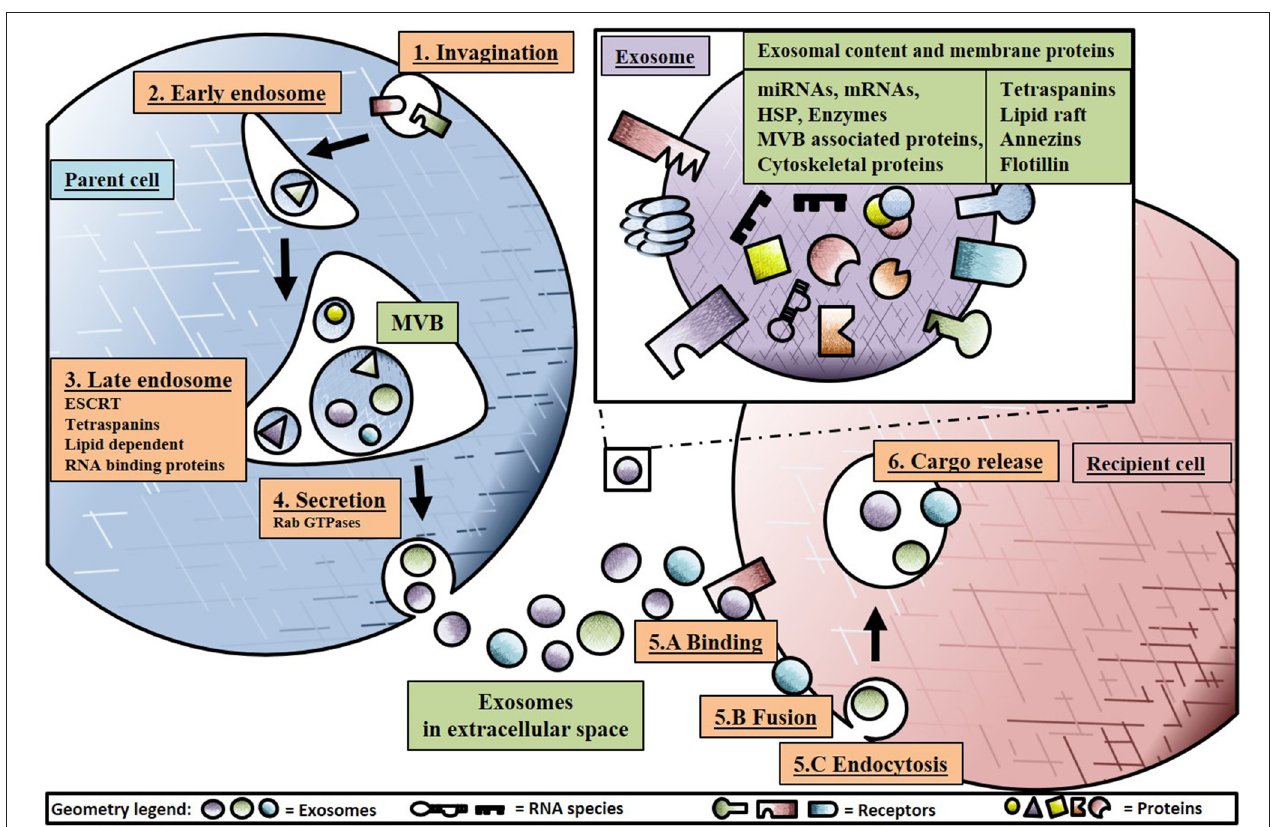
FIGURE 1 | Schematic overview of exosome biogenesis and secretion. Starting at 1: Invagination of the plasma membrane, transporting intraluminal vesicles (ILVs) to 2. The early endosome fusing into multivesicular bodies (MVBs) 3. Formation of the late endosome loading exosomes with RNA cargo loading through Y-Box protein 1 (YBX1) and endosomal sorting complexes required for transport (ESCRT) and secreting 4. Through Rab GTPases into the extracellular space, homing exosome in to the recipient cell through 5.A Binding to receptors, 5.B Fusion with plasma membrane or 5.C Endocytosis with modulators such as extracellular signal-regulated kinase 1/2 (ERK1/2) and phosphoinositide 3-kinase (PI3K) pathways, 6. Releasing cargo in the intracellular space of the recipient cell inducing paracrine signaling